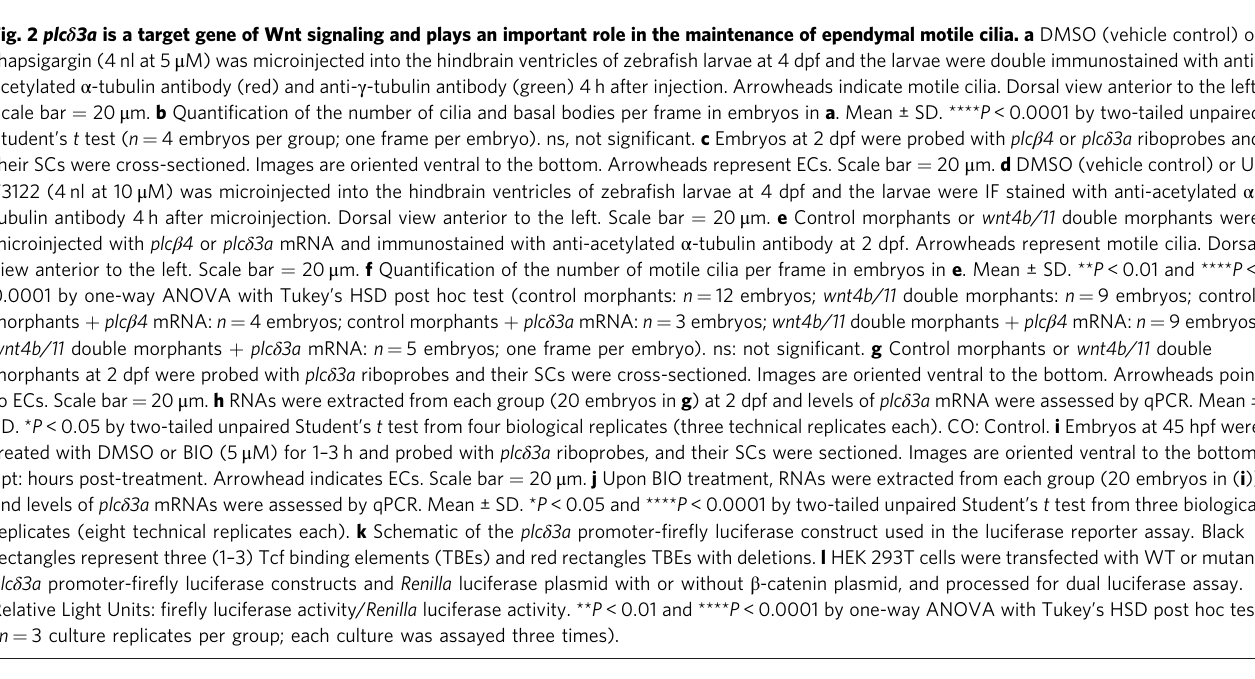
rectangles represent three (1 – 3) Tcf binding elements (TBEs) and red rectangles TBEs with deletions. l HEK 293T cells were transfected with WT or